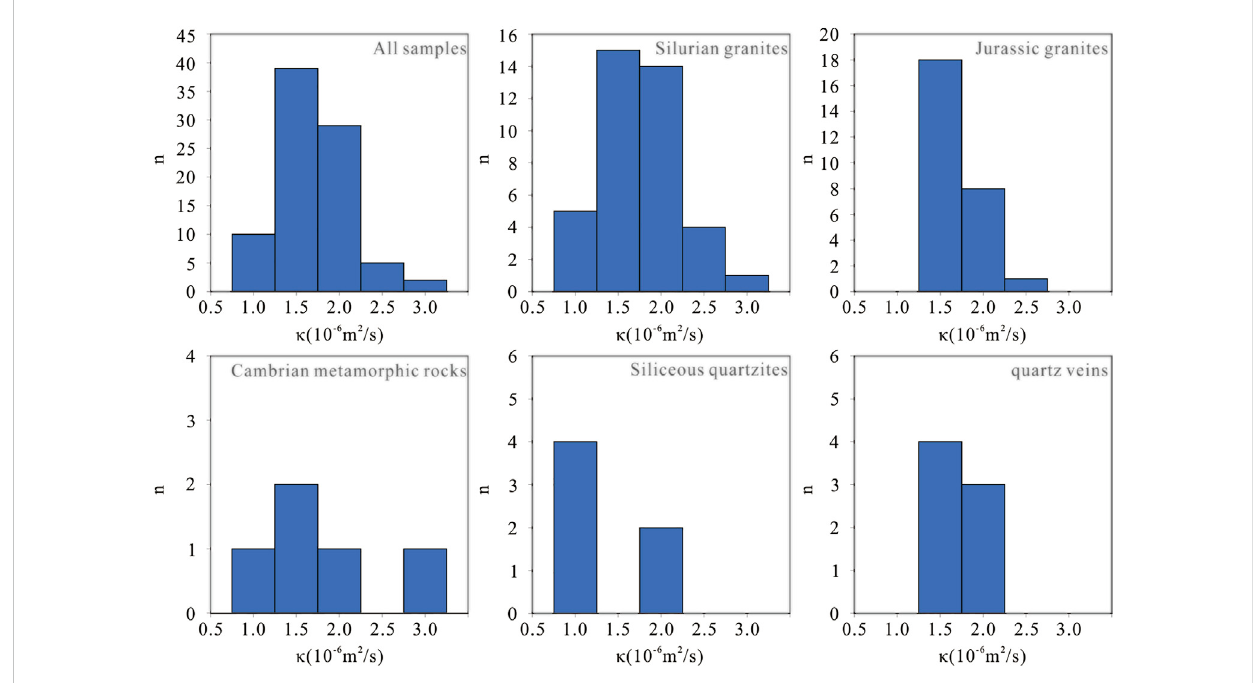
FIGURE 9 Superposition diagram of the geothermal geological map with thermal diffusivity